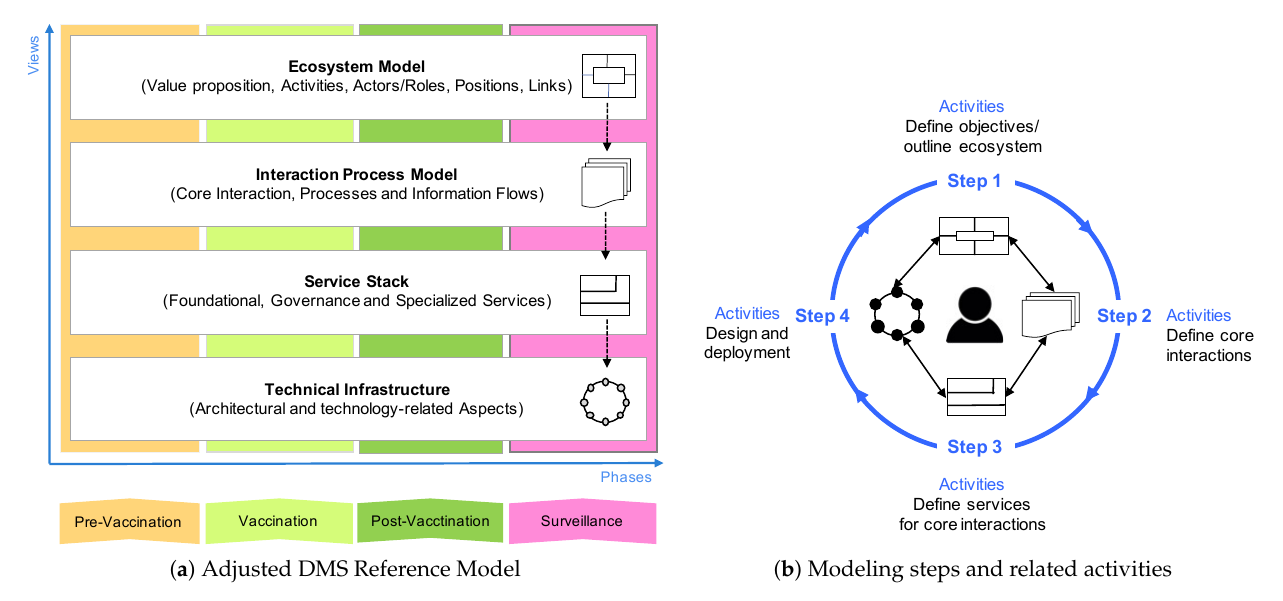
Figure 5. COVID-19-Vacc Platform modeling